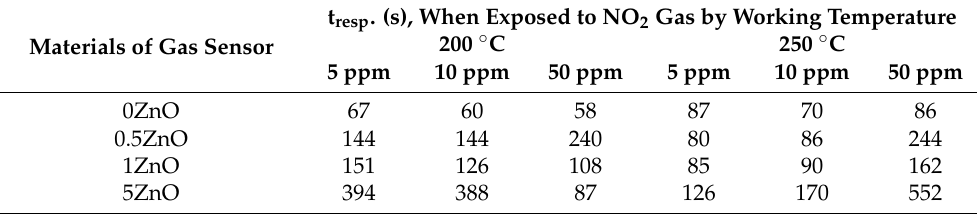
Table 4. Response time of ZnO-SnO 2 films to NO 2 exposure.